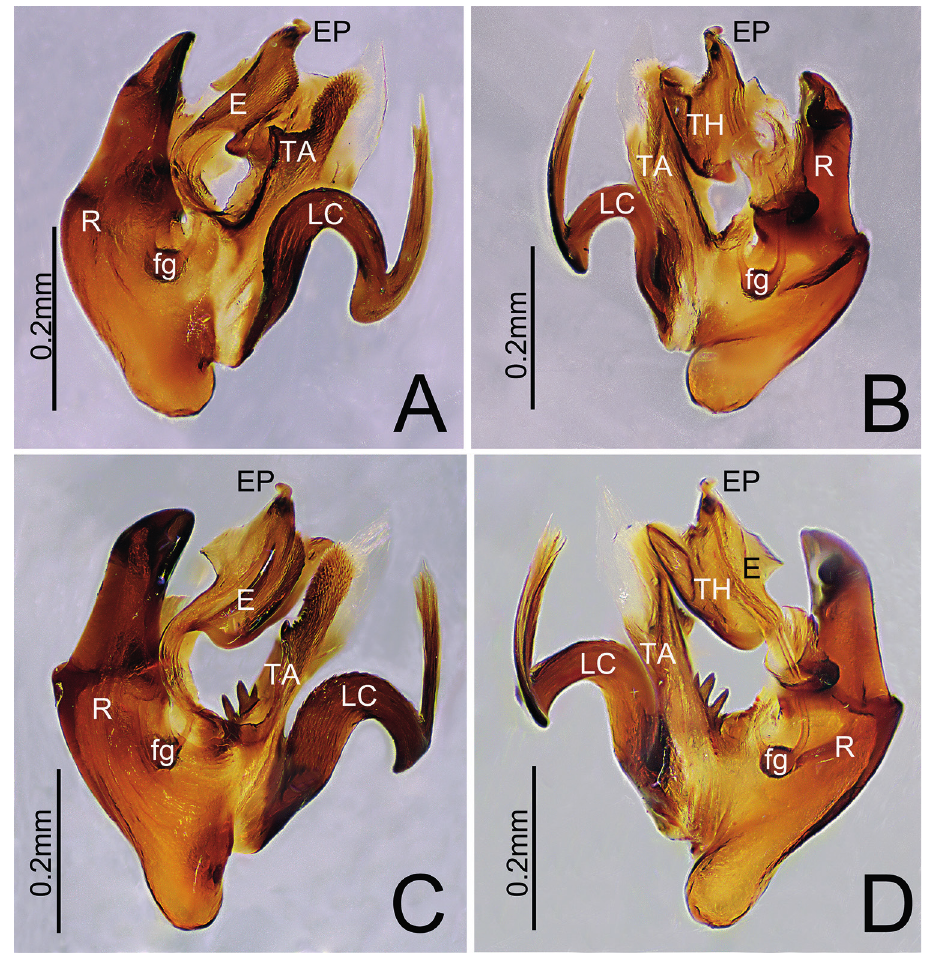
Figure 3. A, B Himalaphantes lingulatus sp. nov., holotype ♂ C, D Himalaphantes uncatus sp. nov., holotype ♂ A, C embolic division, prolateral view B, D embolus, retrolateral